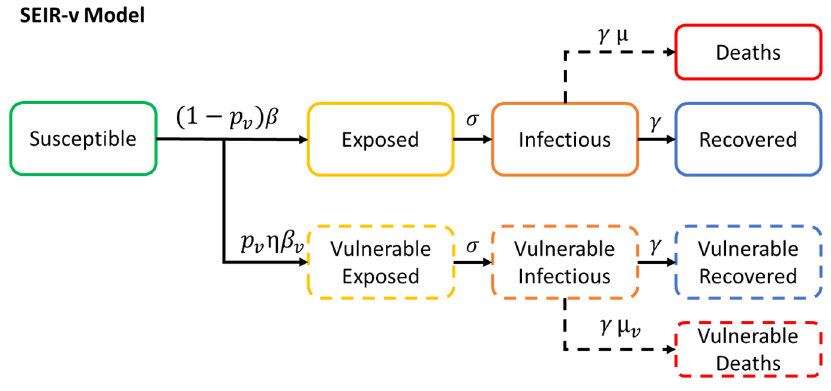
Figure 3. SEIR-v epidemiological model.